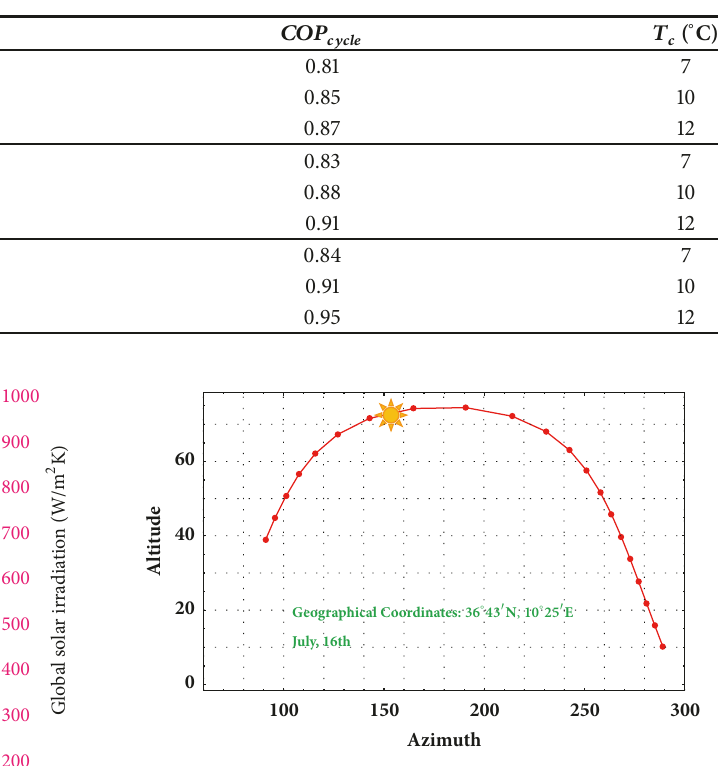
Figure 8: Solar chart for a typical summer day in Tunis-Tunisia (8:00–18:00 in 0:30